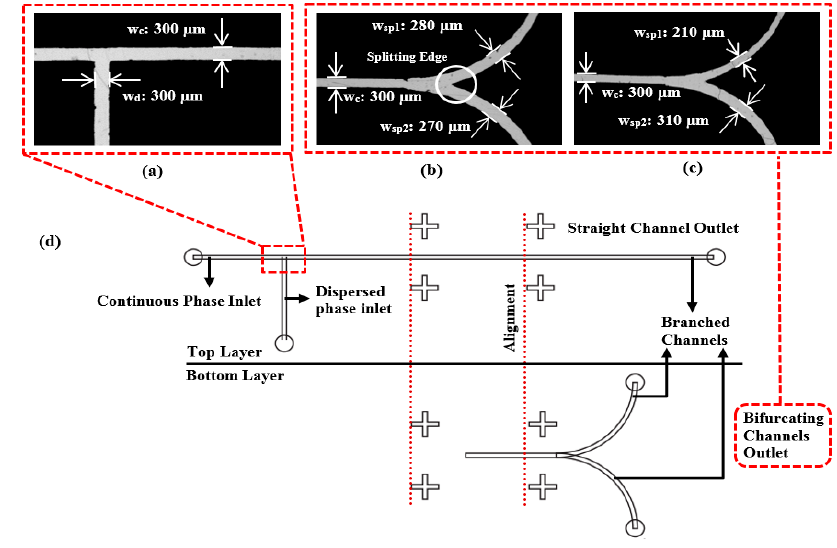
Figure 1. Images of xurographic positive-tone microchannel: ( a ) T-junction and bifurcated junction with ( b ) even (1:1) and ( c ) uneven aspect ratio (2:3) (where w d denotes as the dispersed phase channel, w c denotes as continuous phase channel, w sp1 denotes as first splitting junction and w sp2 denotes as second splitting junction, respectively). The sample images were taken using optical microscope using 2 × magnification. ( d ) Design of the microchannels composed of T-shaped and bifurcating channels using CorelDraw Graphics Suites X7. The red dotted line denotes the alignment profile of the bilayer microchannels.